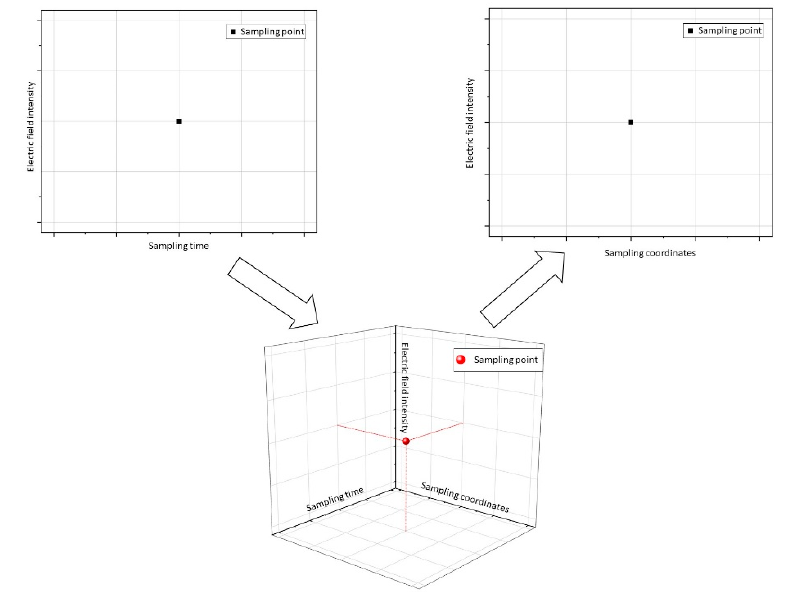
Figure 14. Spatiotemporal information fusion